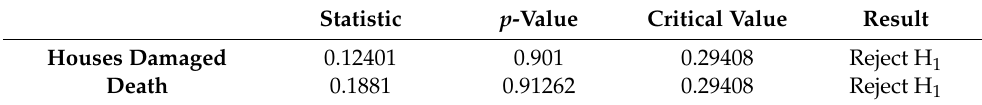
Table 2. The Kolmogorov–Smirnov Test for houses damaged and deaths.